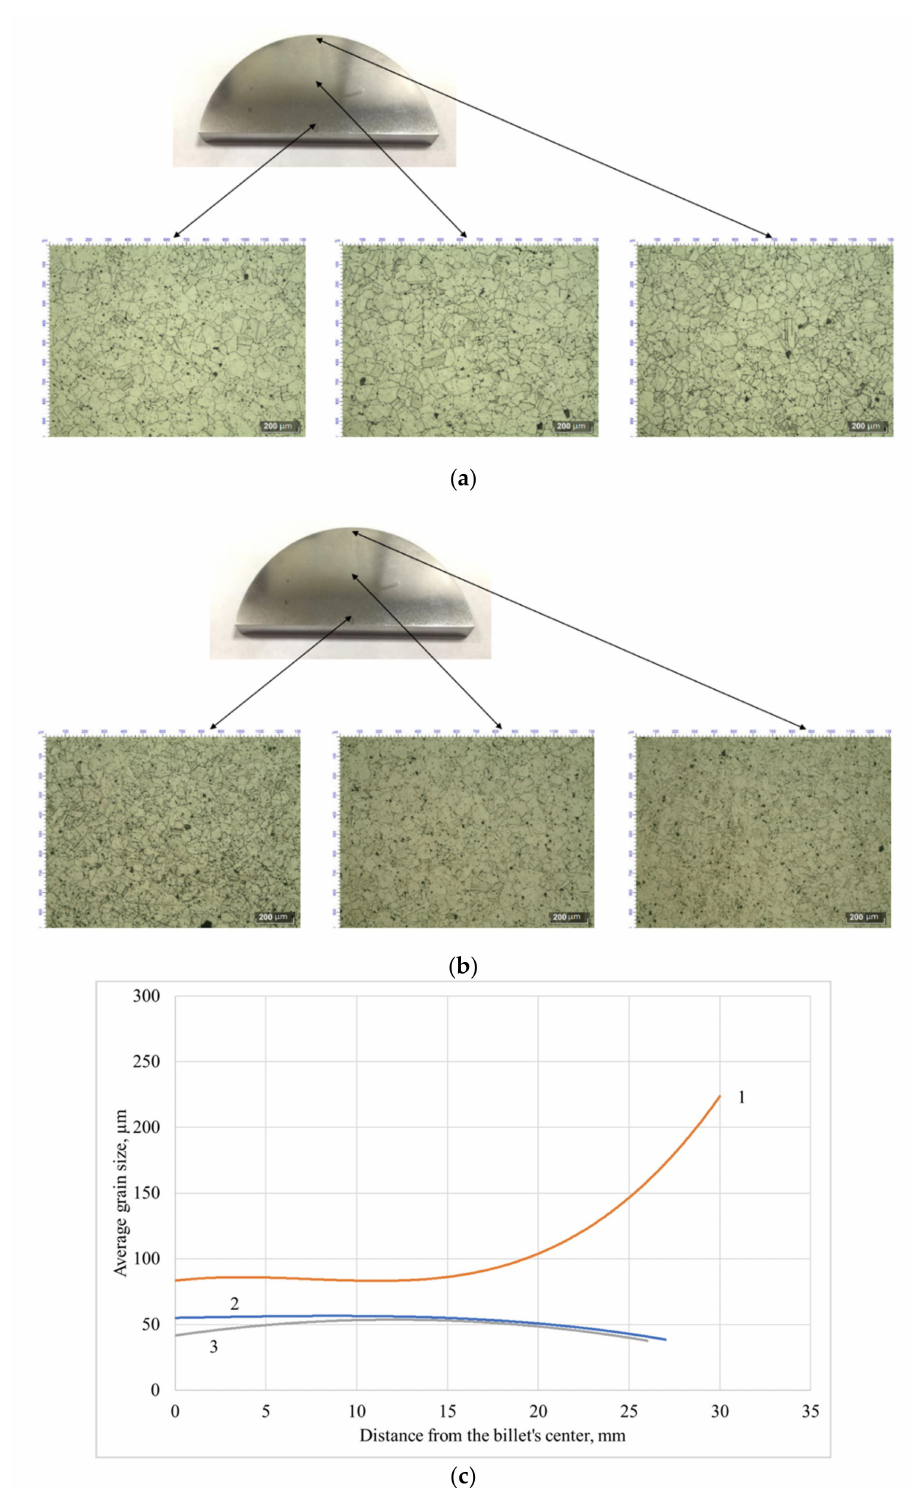
Figure 3. Microstructure of the billet at the stationary stage after two- ( a ) and three-high screw rolling ( b ), and change of the average grain size ( c ) of the reference billet (1), the billet after two-high screw rolling (2), and the billet after three-high screw rolling